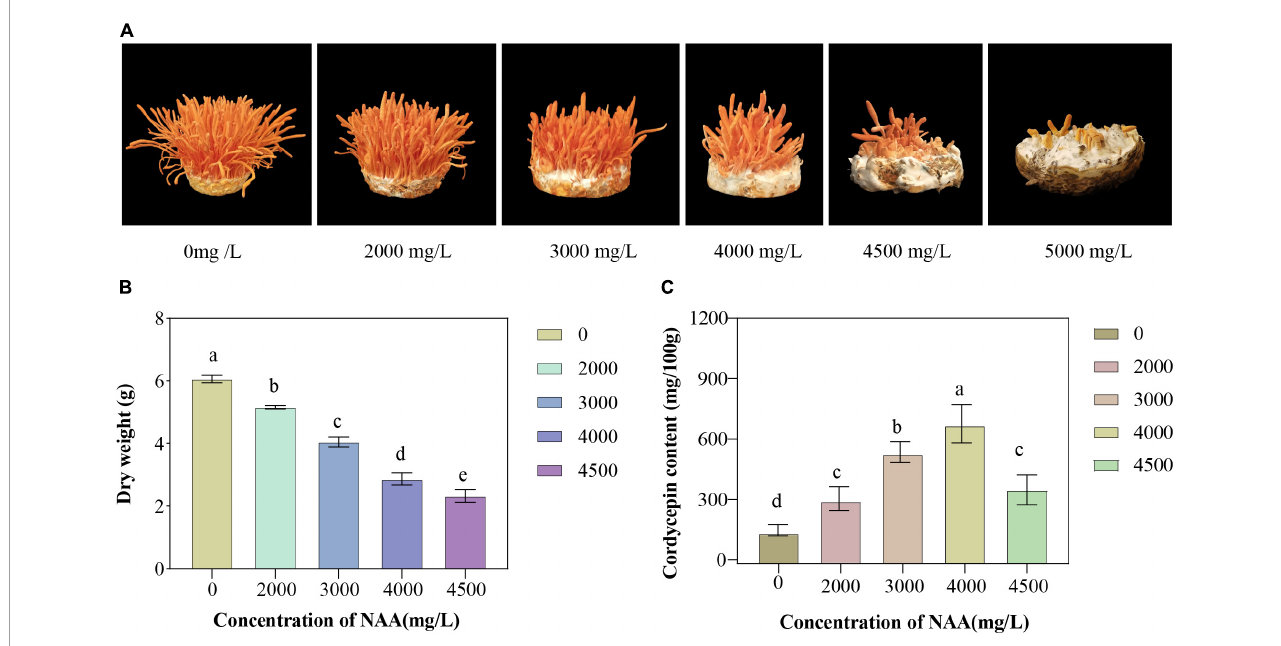
FIGURE1 Growth characteristics, fruiting body dry weight, and cordycepin content of Cordyceps militaris after naphthalene acetic acid (NAA) treatment. (A) Growth morphology of C. militaris fruiting body treated with different concentrations of NAA. (B) Effects of different concentrations of NAA on C. militaris fruiting body dry weight. (C) Effects of different concentrations of NAA on cordycepin content. Data were analyzed with Duncan’s multiple range test. Different letters indicate significant differences ( P <